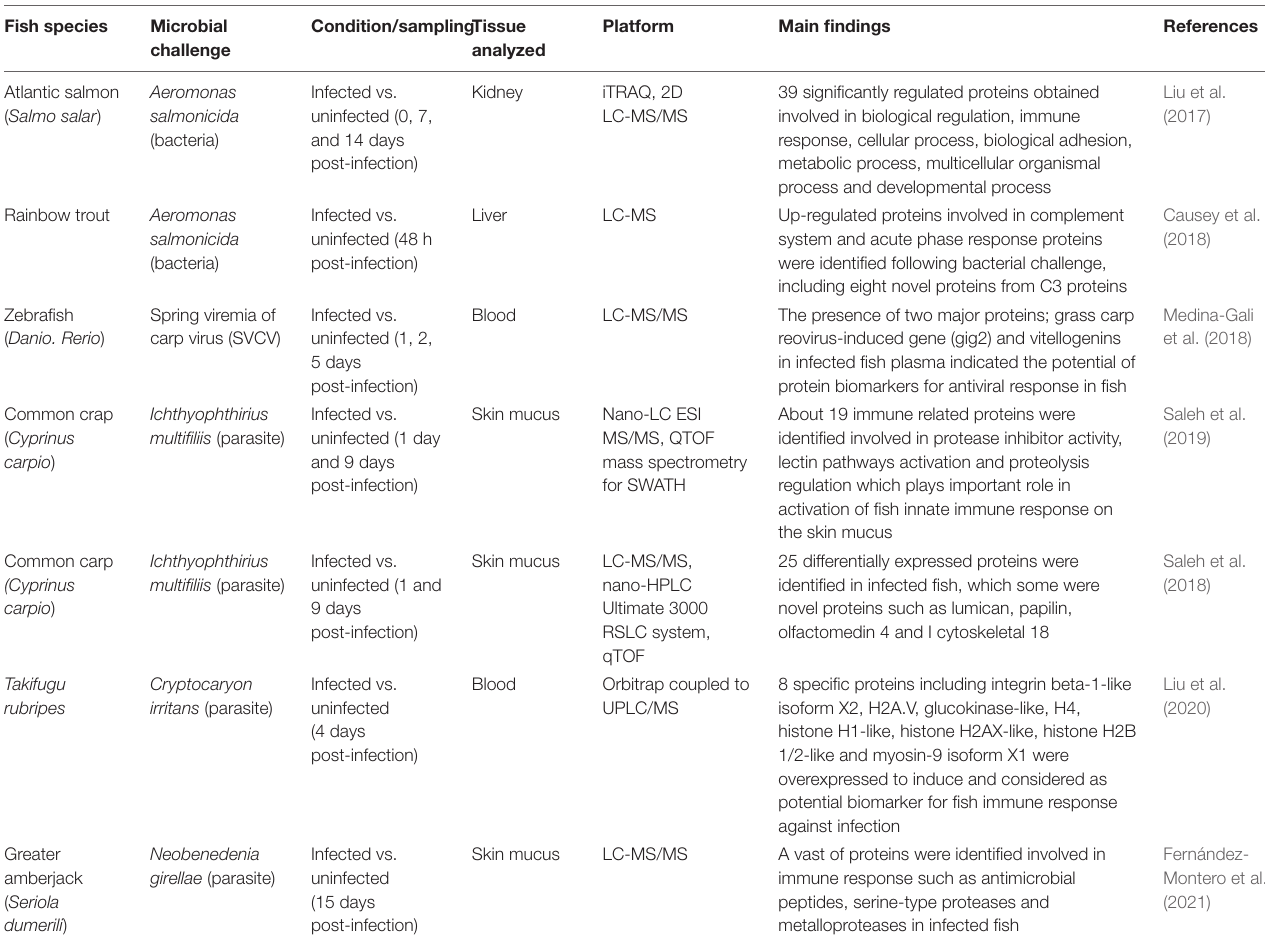
TABLE 3 | Summary of fish immune response study using proteomics